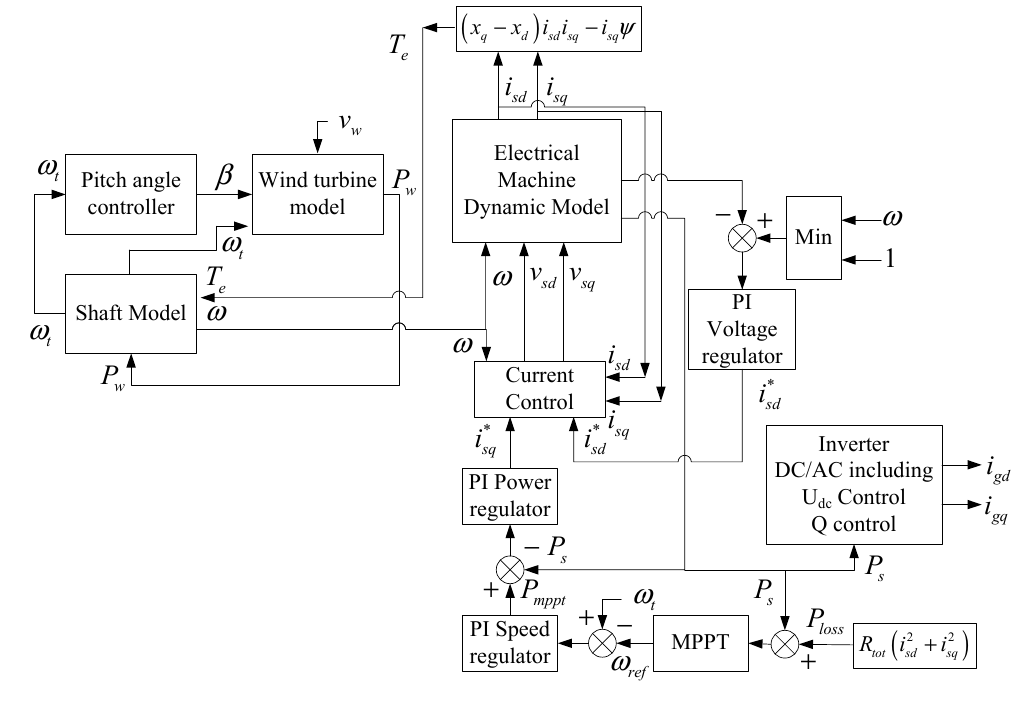
Figure 16. Final control scheme.